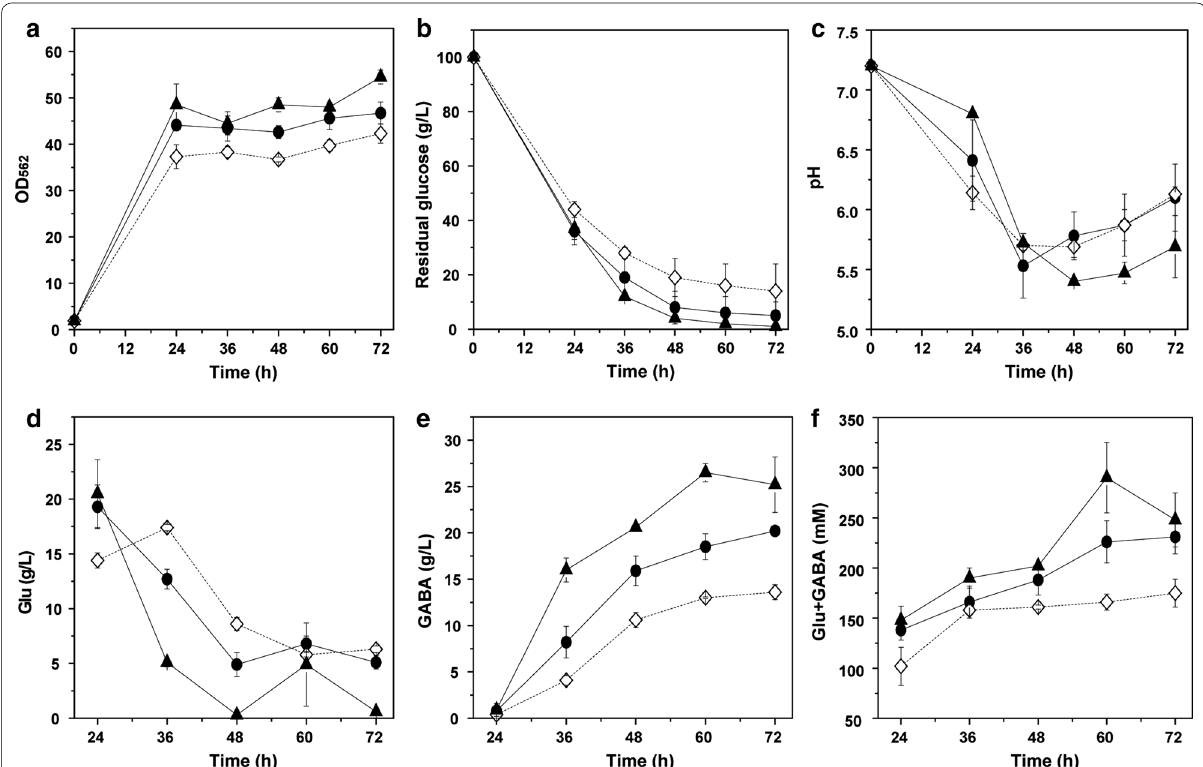
Fig. 7 GABA fermentation of gadB2 , gadB1 mut and gadB2 - gadB1 mut expressing C. glutamicum strains under P tacM promoter and R4a RBS sequence. a Cell growth, b glucose consumption, c pH variation, d Glu production, e GABA production, f total amount of Glu and GABA. Circles R4a-B2, empty diamonds in dotted line R4a-B1 mut , triangles R4a-B2B1 mut . Averages of three independent experiments are